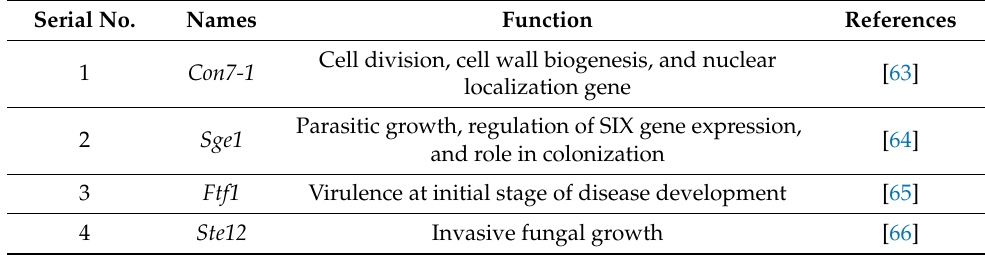
Table 3. Seven major transcriptional factors responsible for pathogenicity in F. oxysporum . Serial